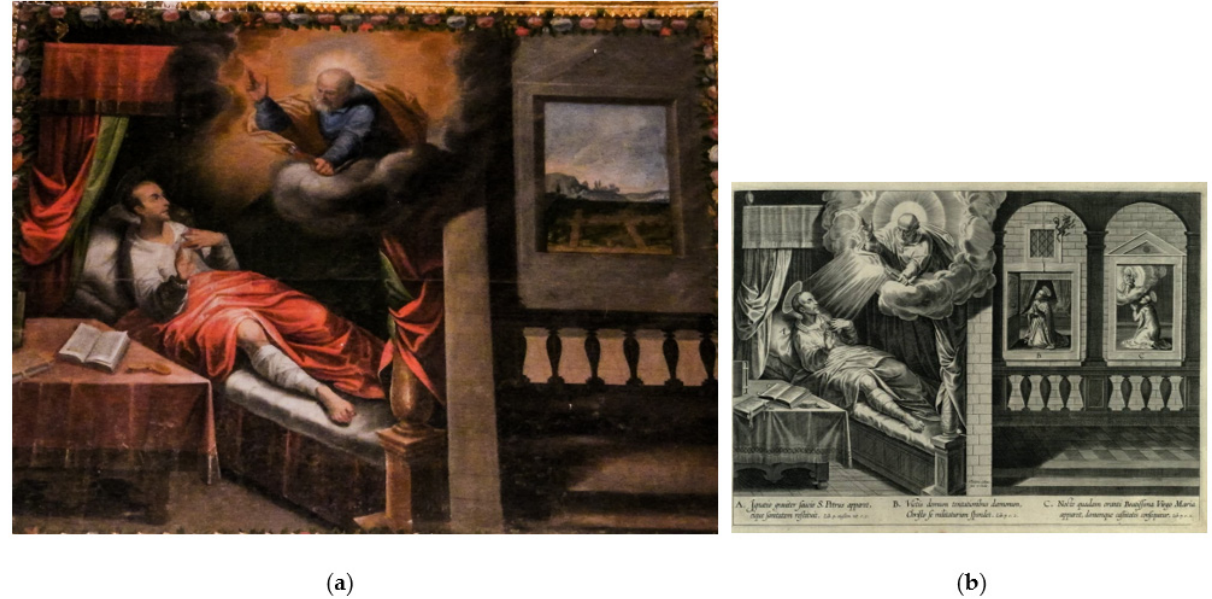
Figure 7. ( a ) Unidentified Cuzco artist, Saint Peter Appears to Saint Ignatius , 17th century, oil on canvas, Iglesia de San Pedro, Juli, Puno, Peru. Credit line: Sebastian Ferrero. ( b ) Theodor Galle (1566–1638), Saint Peter Appears to Saint Ignatius. Ignatius resists temptation through prayer. The Virgin Mary and the child appear to Saint Ignatius , 1610, engraving. In Pedro de Rivadeneira, S.J., Vita Beati Patri Ignatii Loyolae, Religionis Societatis Iesu Fundatoris . Credit line: Boston College Libraries from PESSCA (Project on the Engraved Sources of Spanish Colonial Art).